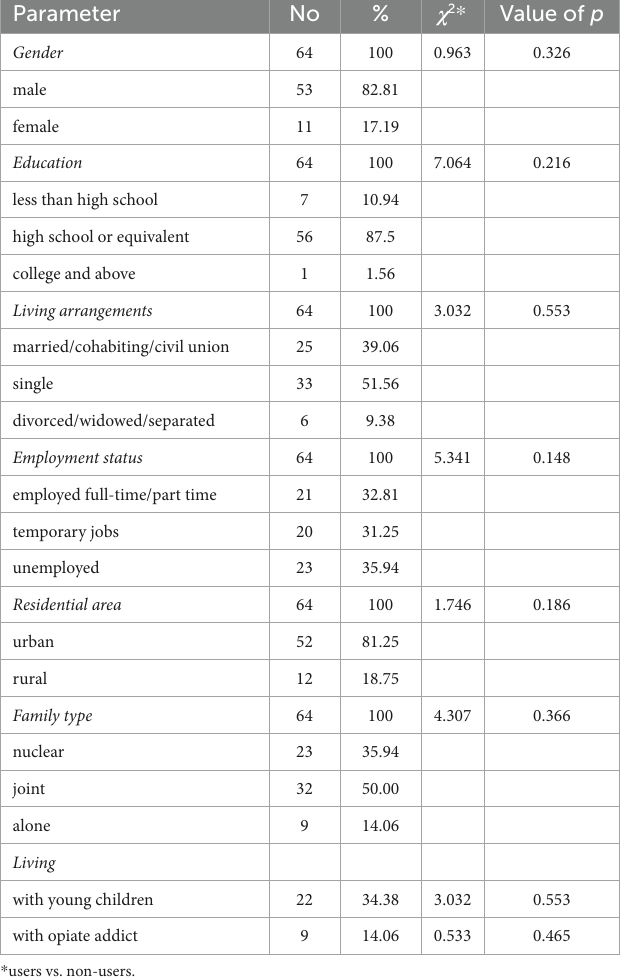
TABLE 1 Socio-demographic characteristics of the respondents ( N = 64).